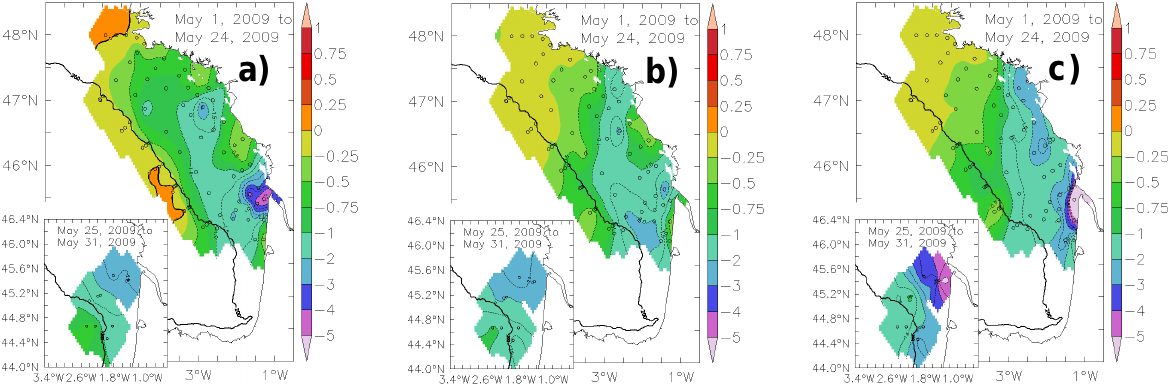
Figure 12 : Surface minus near bed temperature difference (°C) for observation (panel a), V2 system (panel b) and V1 system (panel c).